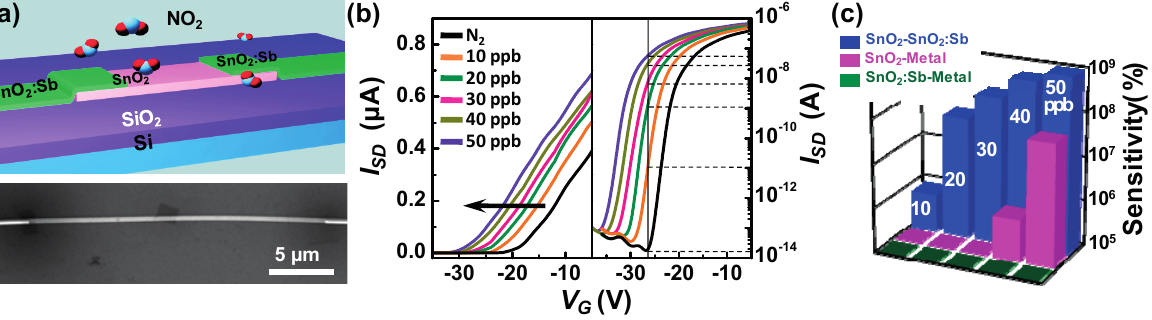
Figure 10. ( a ) Schematic and SEM image of the SnO nanobelt field-effect gas sensor with 2 SnO :Sb nanobelts as electrodes; ( b ) Transfer characteristics of the device to various NO 2 concentrations (0, 10, 20, 30, 40 and 50 ppb) at room temperature; ( c ) Comparison of the concentrations (10, 20, 30, 40 and 50 ppb): sensitivity of the devices for different NO 2 SnO :Sb nanobelt with metal electrodes (green), SnO nanobelt FET with metal electrodes 2 2 (red), and SnO nanobelt FET with SnO :Sb electrodes (blue) 2 2